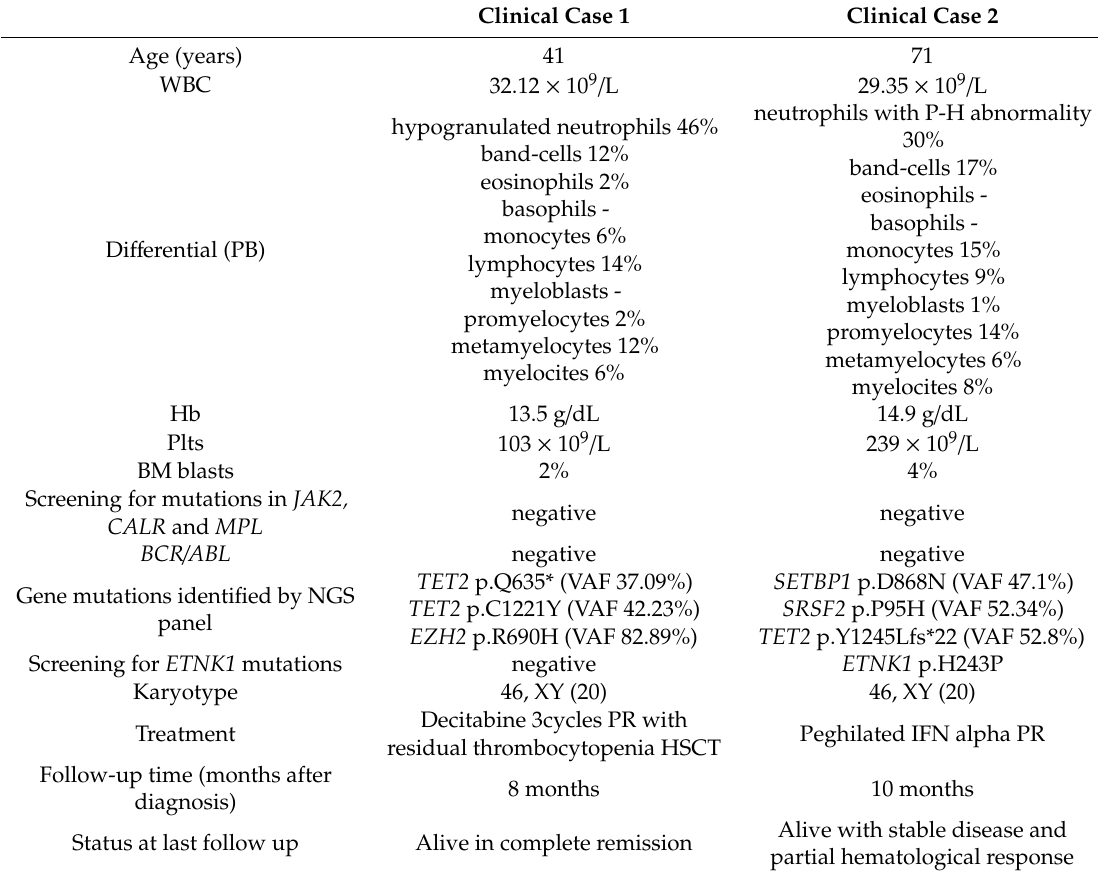
Table 1. Characteristics at Diagnosis and Outcome of the Two Clinical Cases of